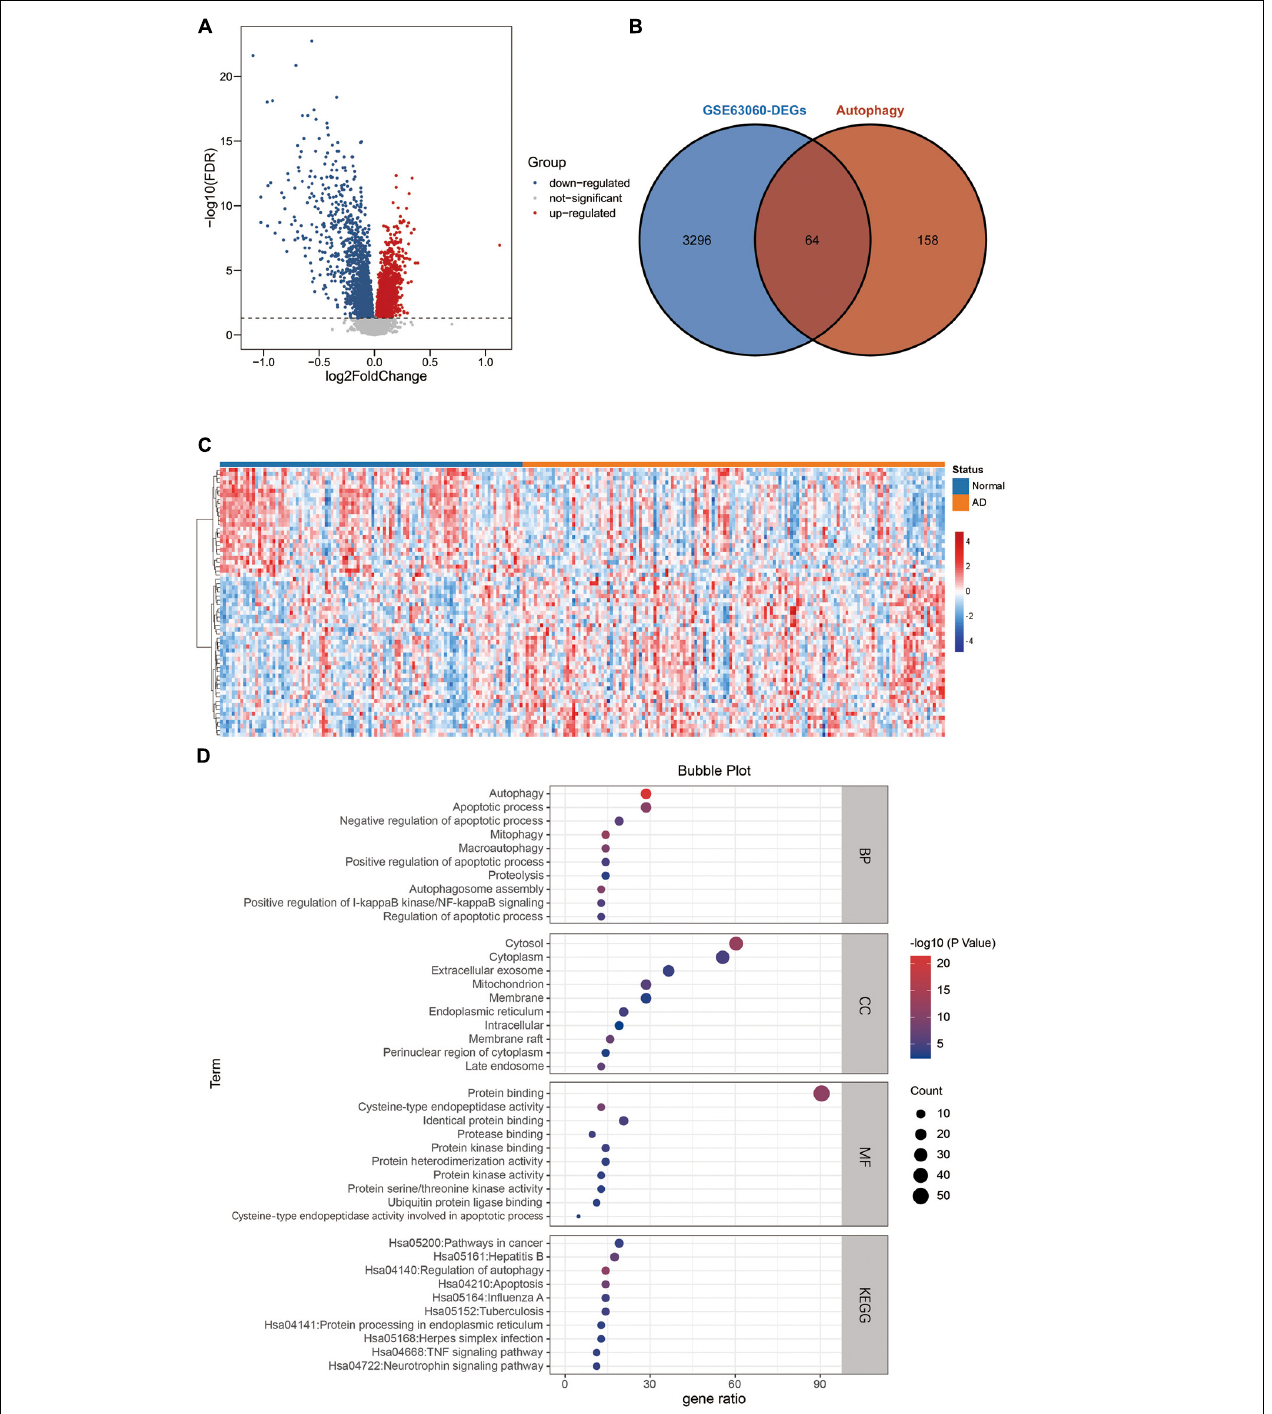
FIGURE 2 | Differentially expressed ATGs. (A) The volcano plot for differentially expressed genes in GSE63060. Red represents upregulated genes, blue represents downregulated genes, and gray represents non-significant genes. (B) Venn diagram showing the 64 DE-ATGs (the intersection of the DEGs and ATGs). (C) A heatmap of DE-ATGs in GSE63060. (D) Bubble plot of GO analyses and KEGG pathway analysis of DE-ATGs using DAVID BP: biological process, CC, cellular component; MF, molecular function; KEGG, kyoto encyclopedia of genes and genomes.